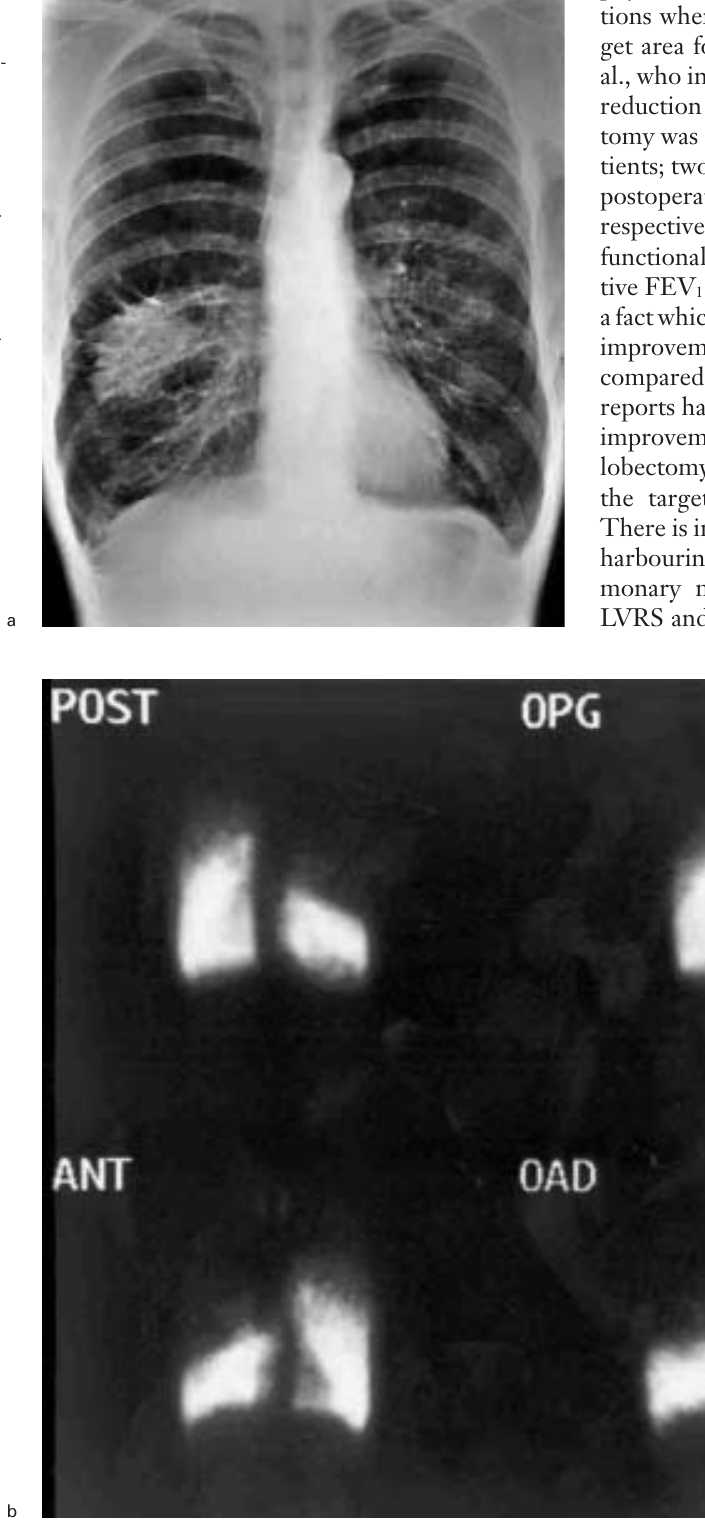
Fig ure 3 Right upper lobe NSCLC in a patient with severe heteroge- neous emphysema with upper lobe pre- dominance, as seen on chest X-ray (fig. 3a) and on pre- operative perfusion scintigraphy (fig. 3b). Preoperative and postoperative FEV